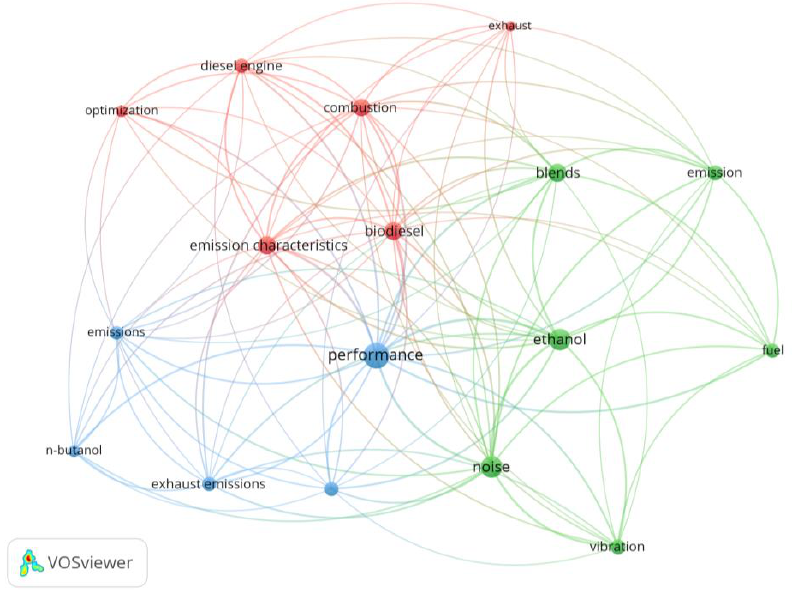
Figure 6. Research topics provided by Web of Science, Clarivate, including noise and alcohol/diesel fuel blends.